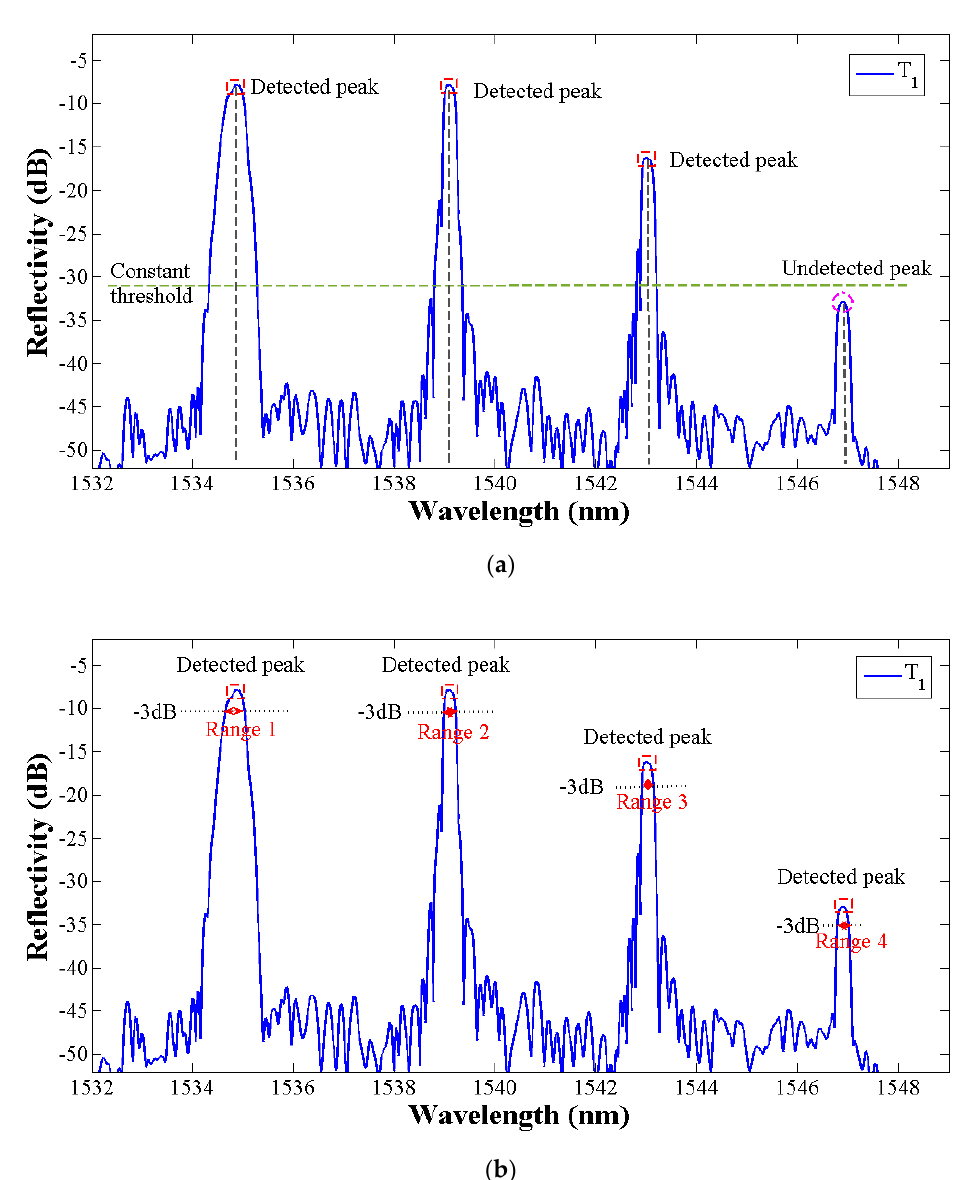
Figure 5. ( a ) Conventional peak detection using a global threshold. ( b ) Peak detection using proposed algorithm.